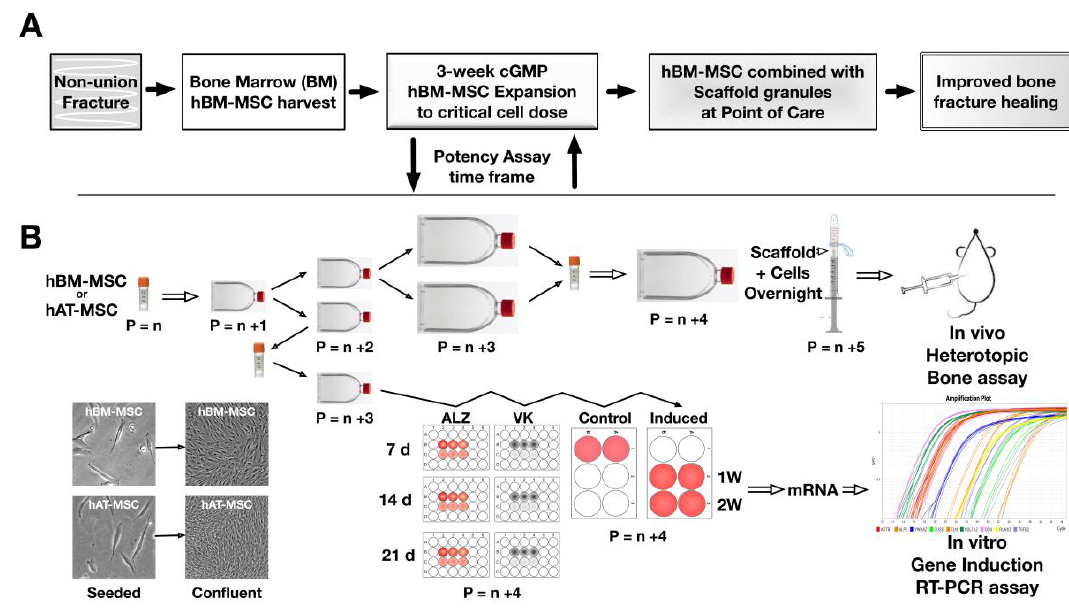
Figure 1. Schematic diagrams of: ( A ) A therapeutic approach for non-union bone fractures applying autologous bone marrow (BM) derived human multipotent stromal cells (hMSC) derived and expanded in culture for 3 weeks under current Good Manufacturing Practice (cGMP). Expanded cell cultures reaching a therapeutic dose were combined with osteogenic sca ff old granules at point of care, with a view to promoting hBM-MSC osteogenic di ff erentiation and improved bone fracture healing. ( B ) Our preclinical stage studies involved expansion of bone marrow derived (hBM-MSC) and adipose tissue derived (hAT-MSC) from frozen primary cell stocks, seeded in monolayer culture flasks, maintained in grow medium until near-confluence before serial passage into flasks. Since o ff -site in vivo experiments required frozen vial transport, congruence was maintained by introducing a cell freezing step before transferring cells to multi-well plates for treatment with osteogenic induction medium. Osteogenic di ff erentiation was assessed by Alizarin Red S (ALZ) and Von Kossa (VK) staining to detect biomineralization at 7, 14 and 21 days, whilst parallel cultures were in osteogenic induction medium for 1 and 2 weeks before harvesting mRNA for quantified real-time PCR analysis of osteogenic signature gene induction relative to non-induced control cells.